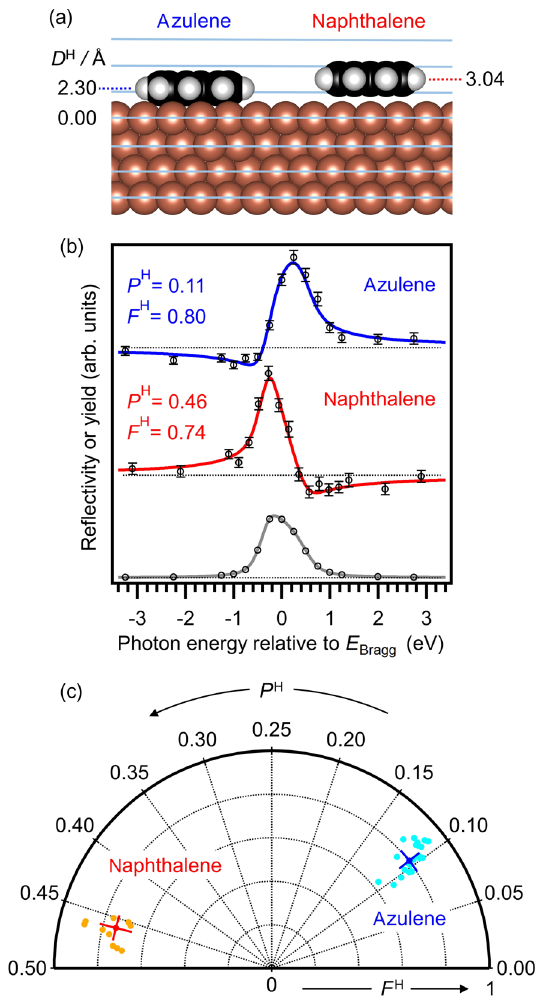
FIG. 2. Adsorption heights from NIXSW measurements for azulene and naphthalene on Cu(111), coverage 1 ML. (a) Space- filling adsorbate models with the heights true to scale as obtained from NIXSW. (b) C 1s photoelectron yields for azulene (top) and naphthalene (center) along with the x-ray reflectivity R ð E Þ (bottom) as a function of the photon energy around the Bragg energy E . The yield data are shown as open circles (with error Bragg bars); the solid blue and red lines are fits with Eq. (1). (c) Argand diagram with the results of the individual measurements in light colors and the averaged value in bold colors, with error